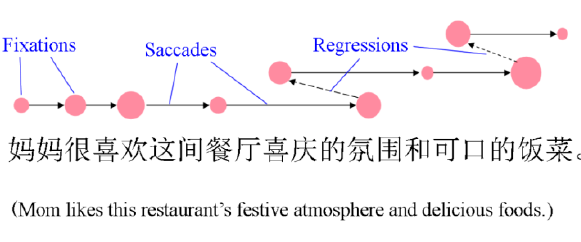
Figure 2. Diagram indicating fixations, saccades and regressions.